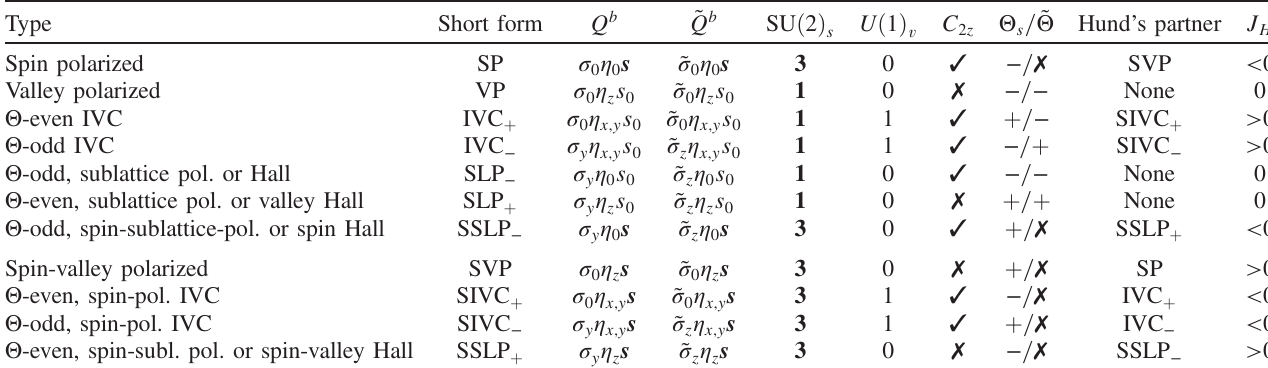
TABLE II. We list the different candidate phases in the TBG-like subspace constructed as the discrete set of states that are part of the large manifold of exact ground states in the chiral-flat-decoupled limit (see Sec. III) but transform under the irreducible representations of the symmetries of the real system. Here, 1 ( 3 ) is the singlet (triplet) representation of SU ð 2 Þ and 0 (1) the one (two)-dimensional s representation of U ð 1 Þ . For future reference, in Sec. VII we list the behavior ( (cid:2) denoting even and odd, and ✗ indicating absence) under v ˜ Θ both spinful ( Θ ) and valley ( ) time-reversal symmetry; see Table I. The last two columns indicate which states are Hund ’ s partners s [27], i.e., transform into each other when reversing the sign of Hund ’ s coupling J while being exactly degenerate in the H [SU ð 2 Þ × SU ð 2 Þ − ]-symmetric limit, and which sign of J favors the respective H þ